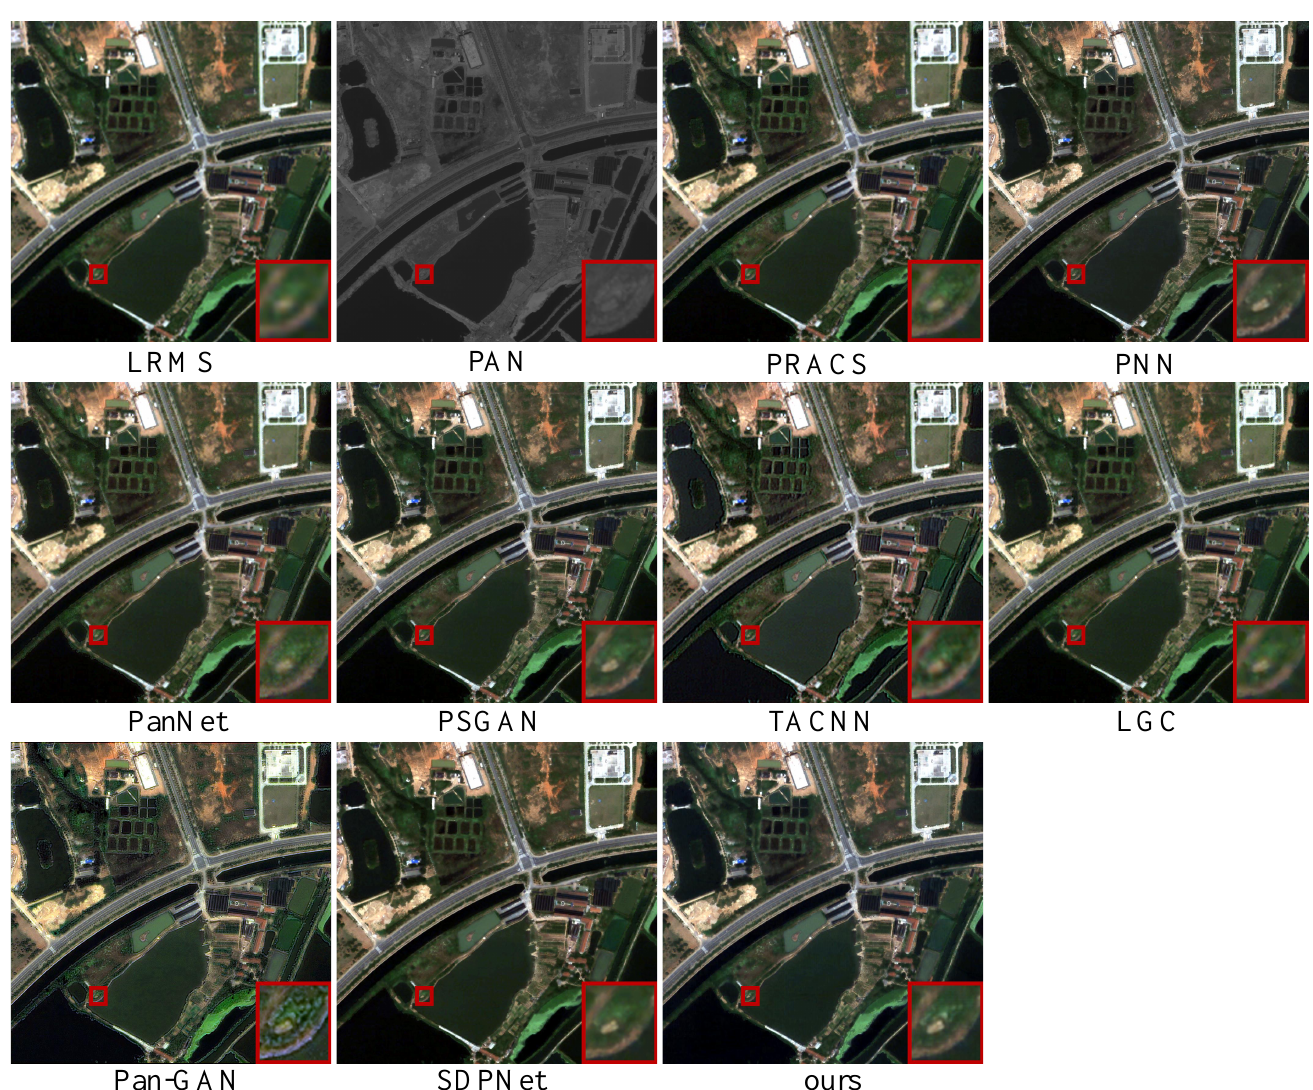
Figure 12. Qualitative comparison of CPNet with other eight pan-sharpening methods on the data from the QuickBird data set in full-resolution